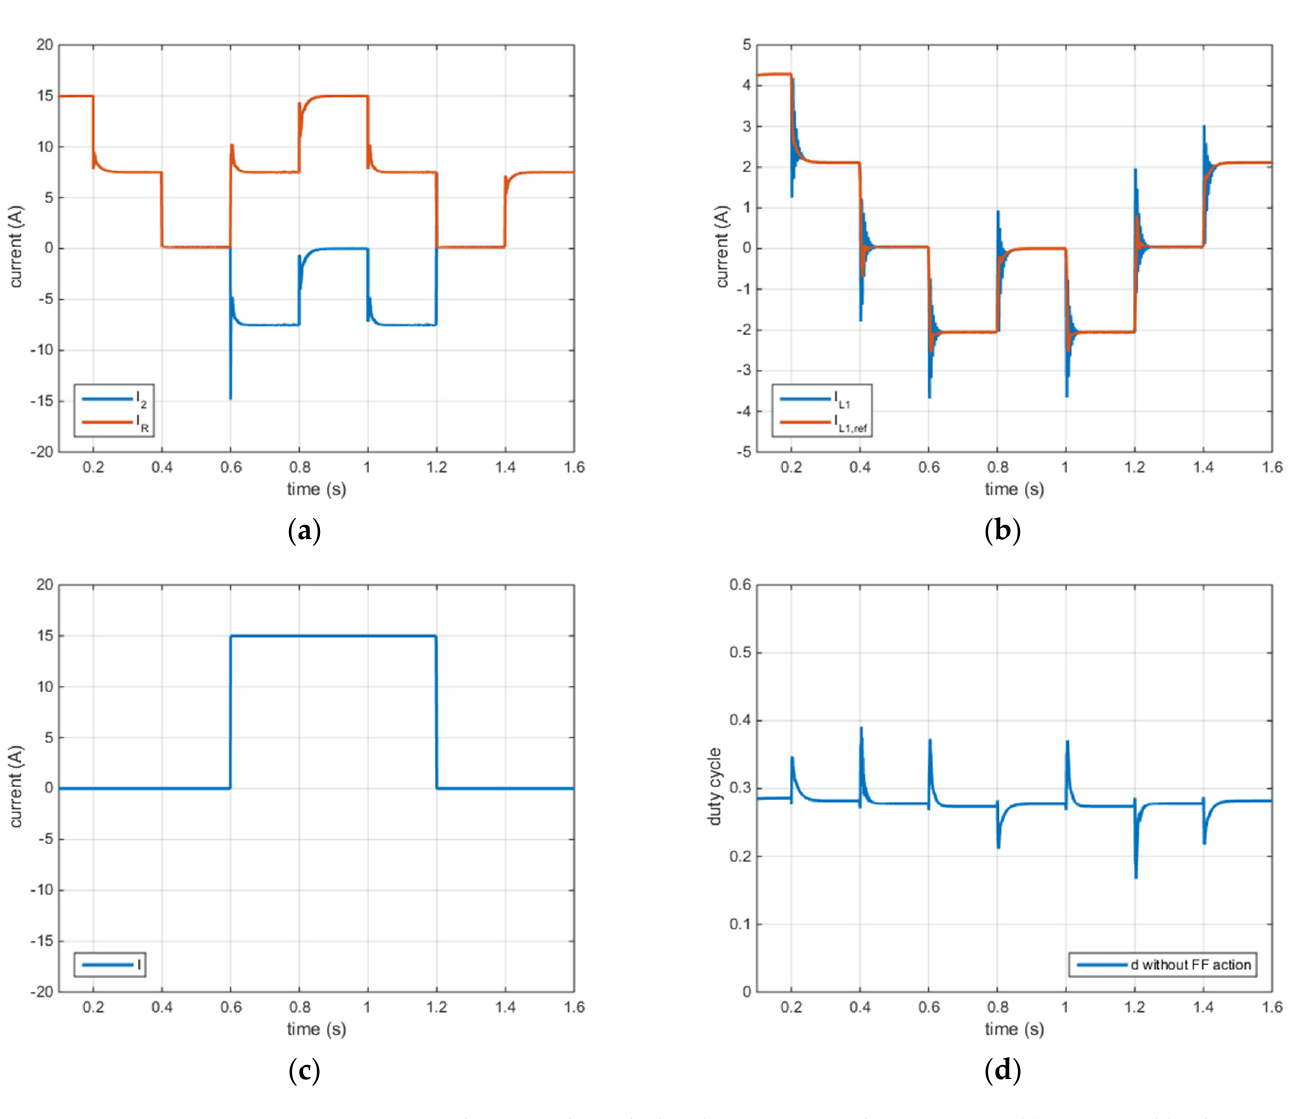
Figure 4. Simulation results in the baseline scenario without FF action: ( a ) output and load currents;